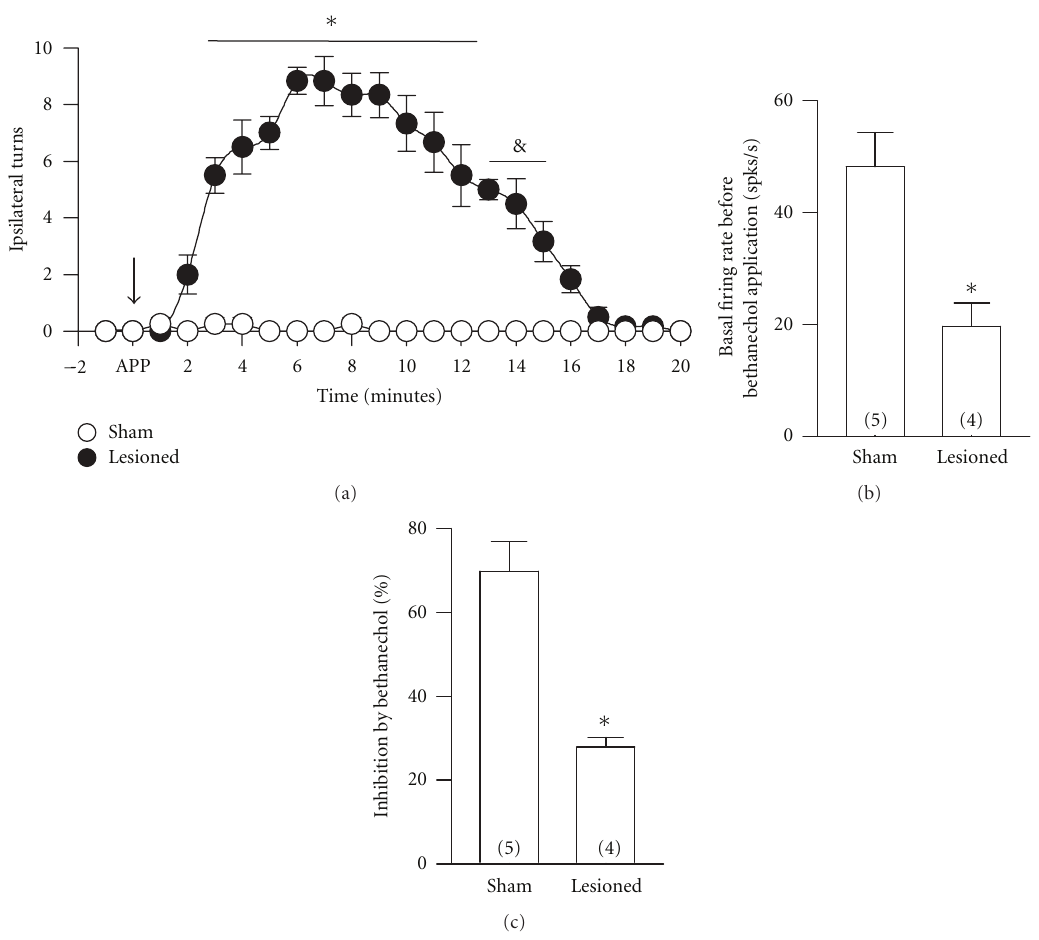
Figure 5: The activation of MRs in the globus pallidus has di ff erential characteristics between sham and ipsilateral striatum-lesioned rats. (a) Intraperitoneal application of apomorphine (0.5mg/kg) induces ipsilateral turning behavior in rats with striatal lesion. ( ∗ P < 0 . 01; & P < 0 . 05, t -test). (b) In sham rats, the predrug (1nmol bethanechol) baseline firing rate was higher in neurons that were inhibited by bethanecol than the baseline firing rate recorded in neurons from lesioned rats that were also inhibited by the same concentration of bethanechol ( ∗ P < 0 . 029, t -test). (c) The percent of inhibition evoked by 1nmol bethanechol is higher in neurons recorded in sham rats than in those recorded in lesioned rats ( ∗ P < 0 . 04, t -test). APP, application time (down arrow); spks/s, spikes per second.